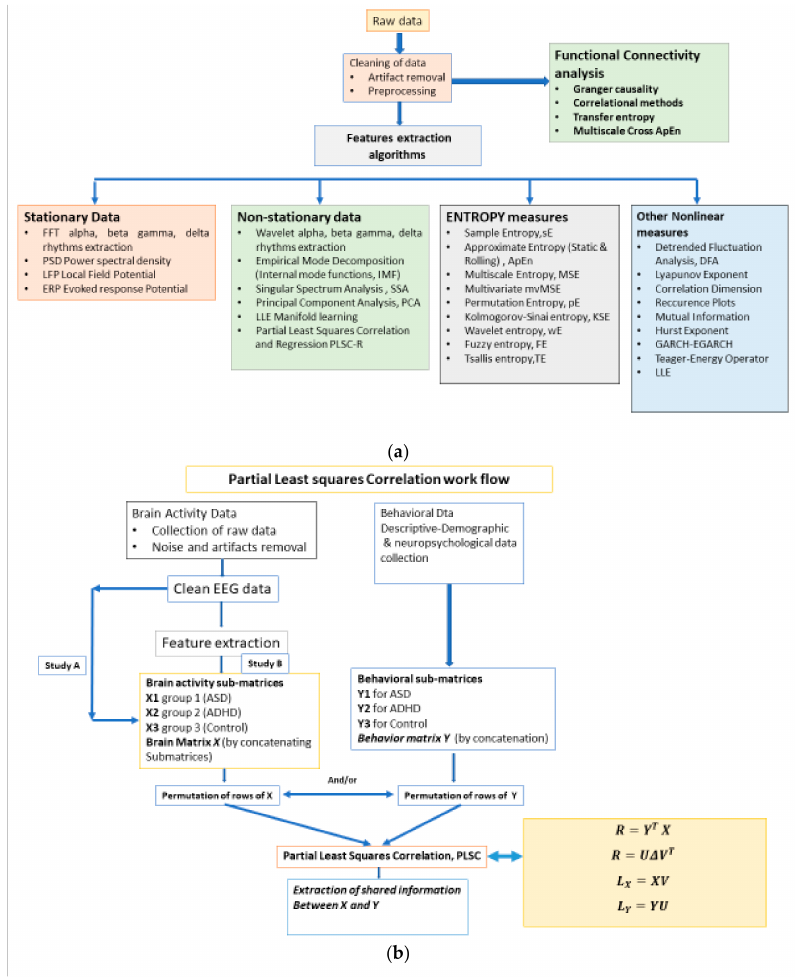
Figure 1. ( a ) An indicative workflow. Our approach (path) is from raw data to preprocessing, Multi Scale Entropy (MSE) in combination with Partial Least Square Correlation, applied on CBD (Cognitive-Behavioral-Demographic) data. ( b ) A work flow of PLSC for analyzing brain and behavioral data in the current study. Entropy values (MSE) were extracted from EEGs and used as input to PLSC (Study